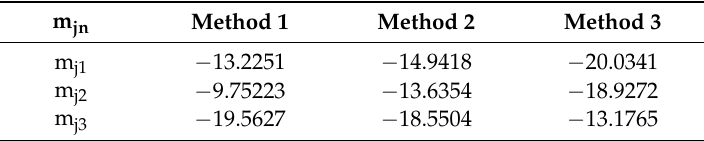
Table 15. Average S/N ratio for heating temperatures.